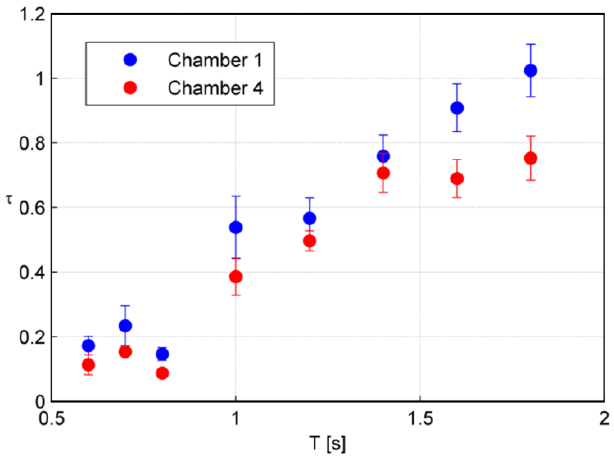
Figure 17. Transfer functions for the front and rear chambers. Error bars account for standard deviations of the data set.